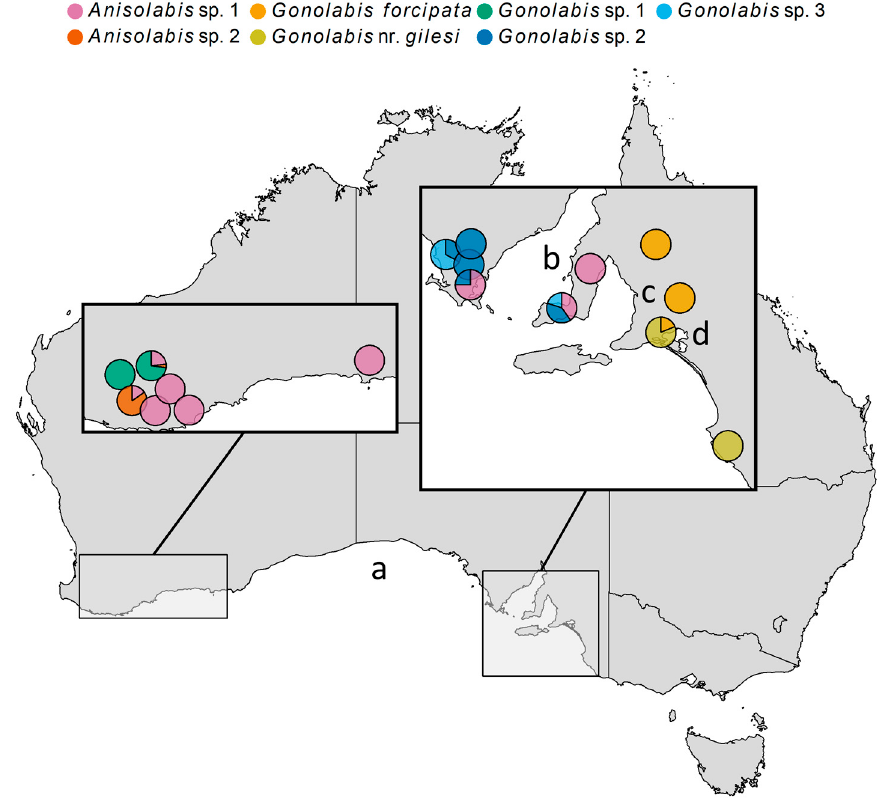
Figure 3. Map of Australia showing locations of collection of Anisolabididae specimens, with pie charts indicating the proportion of each morphospecies found at each site. Some pies have been nudged slightly from their original position to prevent overlapping. Left-inset: Western Australia (WA) sites. Right-inset: South Australia (SA) sites. ( a ) Great Australian Bight. ( b ) Spencer Gulf. ( c ) Adelaide. ( d ) Lake Alexandria.